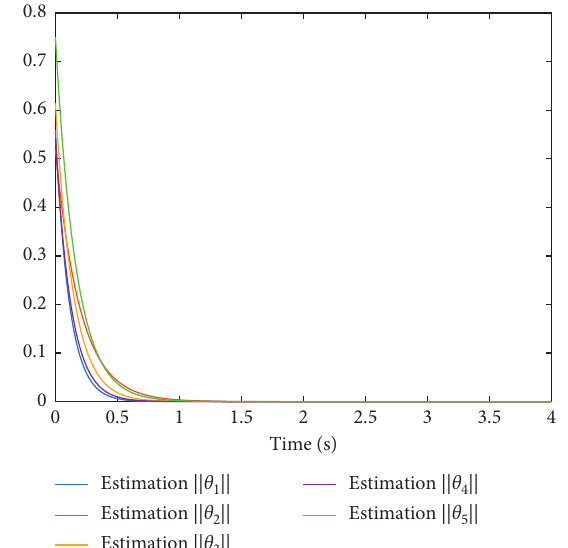
Figure 4: Trajectories of the adaptive estimation parameters θ